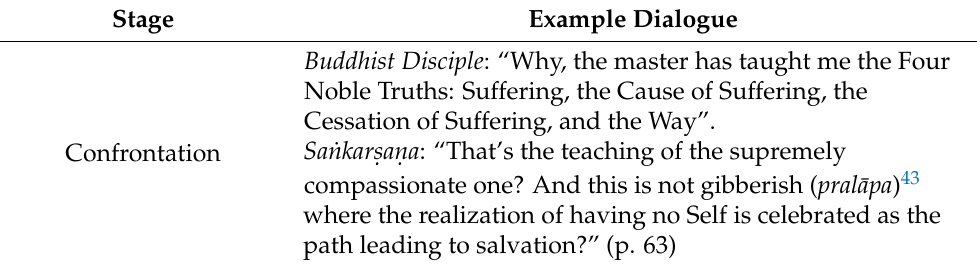
Table 3. Confrontation in Act